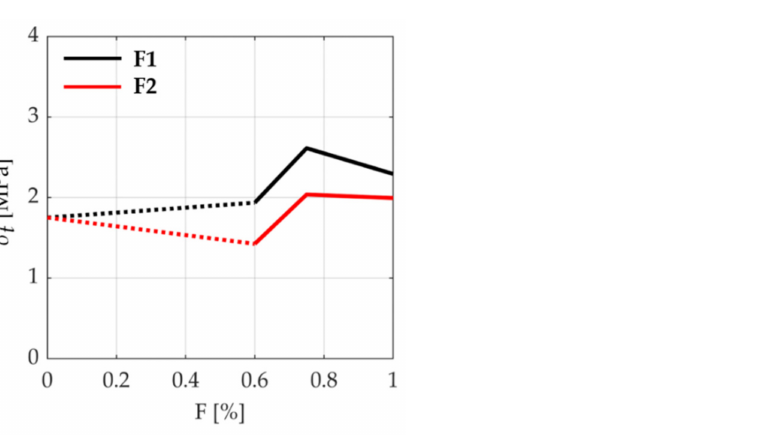
Figure 16. Average tensile strength σ t calculated in the BTs for the fibers, F1 and F2, and three fiber contents, F .